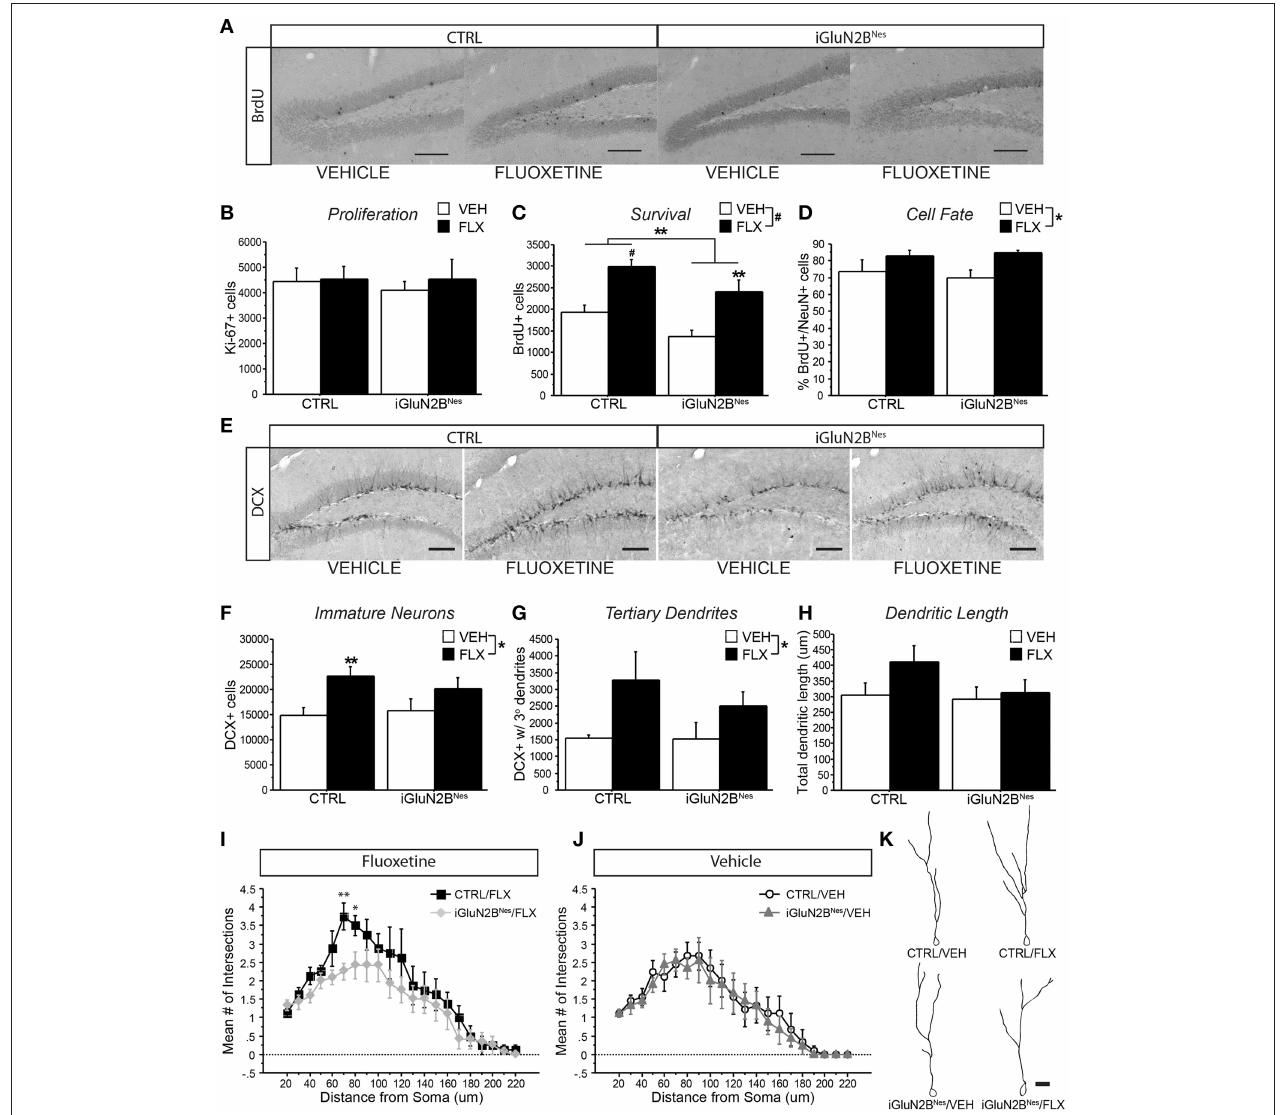
FIGURE 4 | FLX increased dendritic complexity in CTRL but not iGluN2B Nes mice. (A) Representative images of BrdU + cells in the DG (scale bar = 100 µ m) (B) No effect on proliferation was observed as measured by number of Ki-67 + cells. (C) FLX increased survival of abGCs in both CTRL and iGluN2B Nes mice, though overall survival was lower in iGluN2B Nes mice. (D) The majority of BrdU + cells co-labeled with the neuronal marker, NeuN. FLX treatment increased the percentage of BrdU + cells that were neuronal. (E) Representative images of DCX expression in the DG (scale bar = 100 µ m). (F) The number of immature neurons and (G) immature neurons with tertiary dendrites increased following FLX treatment with the most robust effect seen in CTRL mice. (H) There was a trend for FLX to increase total dendritic length of 3-week-old DCX + abGCs in CTRL mice, but not iGluN2B Nes mice. (I) Sholl analysis revealed FLX increased dendritic complexity in CTRL mice, but not iGluN2B Nes mice. (J) GluN2B deletion alone did not affect the dendritic complexity of 3-week-old DCX + abGCs. (K) Representative tracings of 3-week-old abGCs (scale bar = 20 µ m). * p < 0.05, ** p < 0.01, # p <